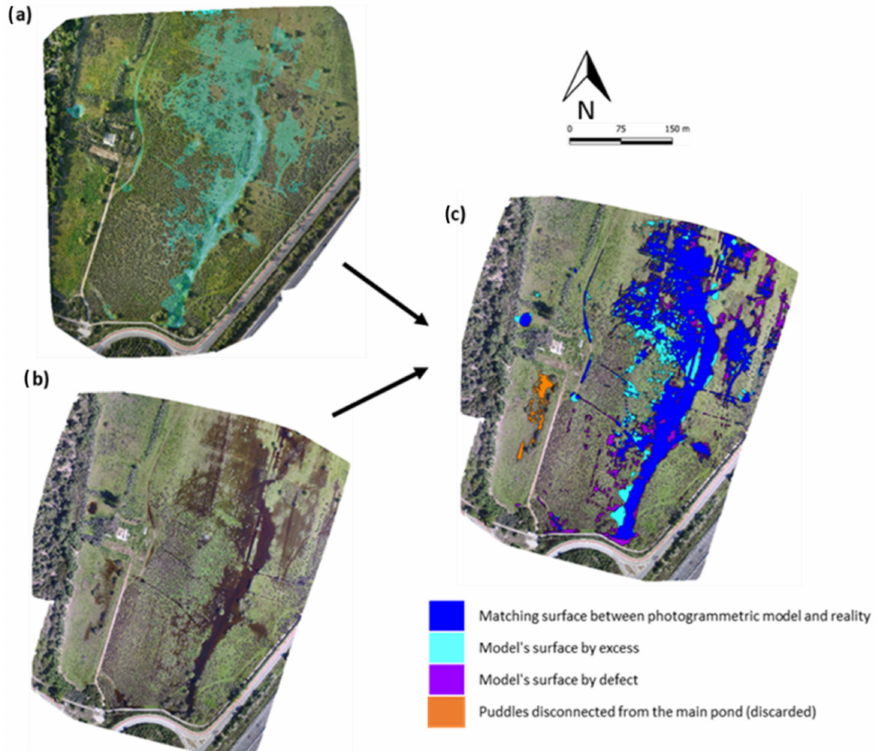
Figure 7. Comparison between the flooded area for a water stage of 1.911 m obtained from the flood photogrammetric model ( a ) and the orthophotography displaying the real flooded area for the same stage on 20 March of 2018 ( b ). ( c ) Displays the matching surface and the differences (by excess and defect) with respect to the real flood extent. The ephemeral puddles located to the W of the trail were excluded from the analysis for being disconnected from the main